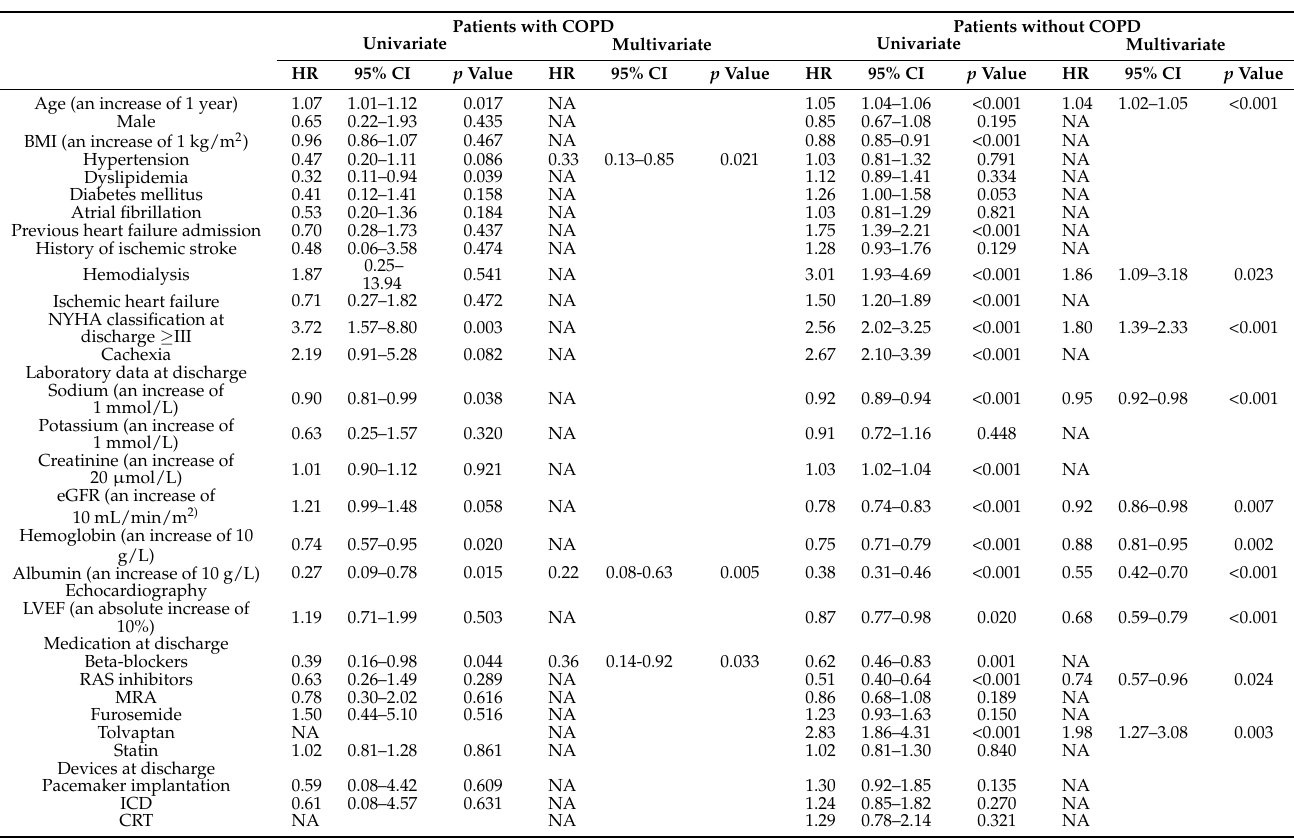
Table 4. Cox regression analysis for all-cause mortality at two